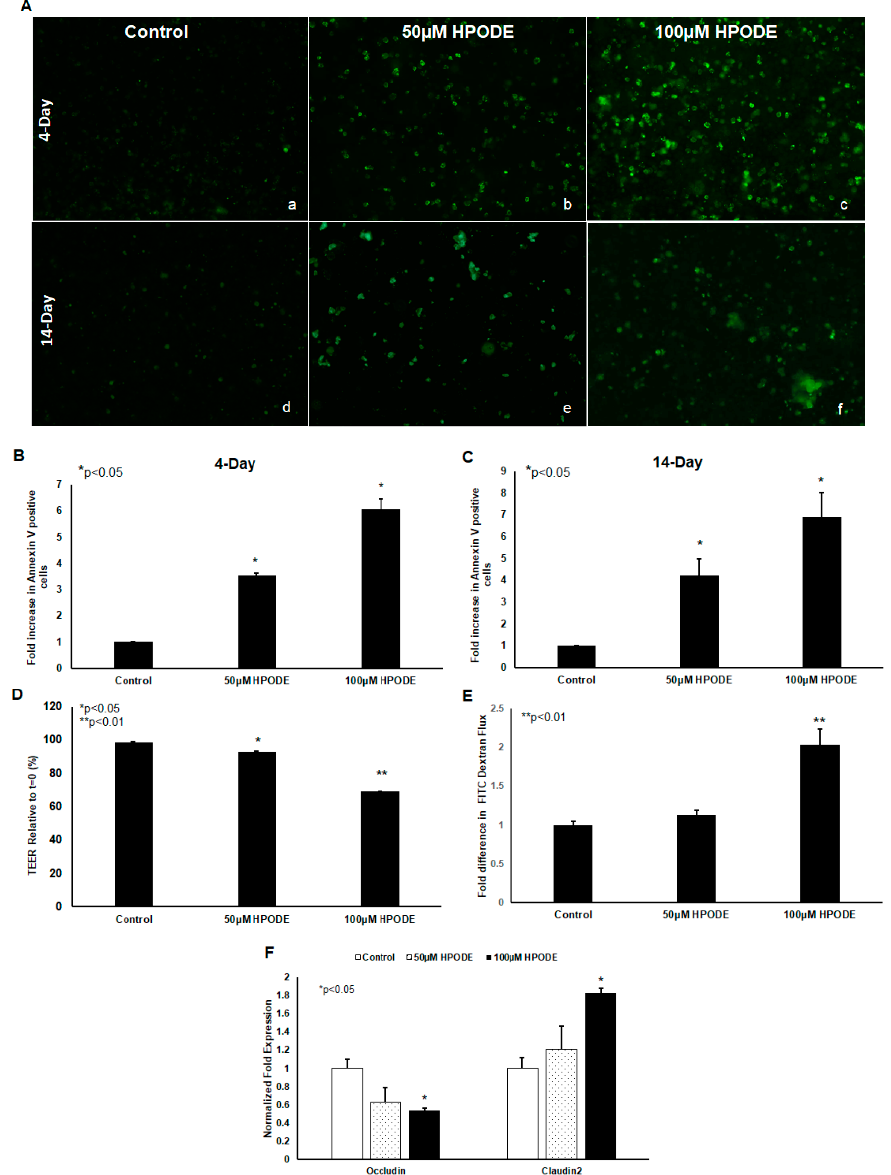
Figure 2. 13-HPODE enhances Caco-2 cell apoptosis (undifferentiated and differentiated cells) and permeability (differentiated cells). Undifferentiated and differentiated Caco-2 cells were incubated with 13-HPODE (HPODE) for 24 h at 37 °C. Annexin V-FITC staining was performed to evaluate the apoptosis and images were recorded, ( A ) ( a – f ). Fluorescence quantification was analyzed by ImageJ ( B , C ). Caco-2 permeability as assessed by TEER measurement ( D ) and FITC dextran flux ( E ). qPCR analysis for tight junction genes Occludin and Claudin-2 in Caco-2 cells treated with 13-HPODE ( F ). Results are represented as mean ± SEM and significance considered as * p < 0.05, ** p < 0.01. FITC, Fluorescein isothiocyanate; TEER, Transepithelial electrical resistance.